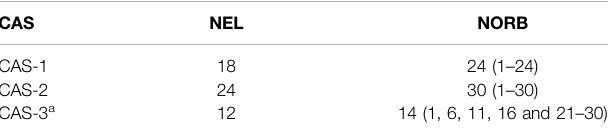
TABLE 1 | The different active spaces (CAS) considered in this work. NEL is number of active electrons and NORB is the number of active orbitals. The numbers in parenthesis indicate the orbital numbers in Figure 2